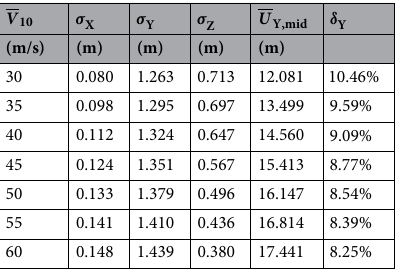
Table 2. Standard deviations of mid-span displacement responses.